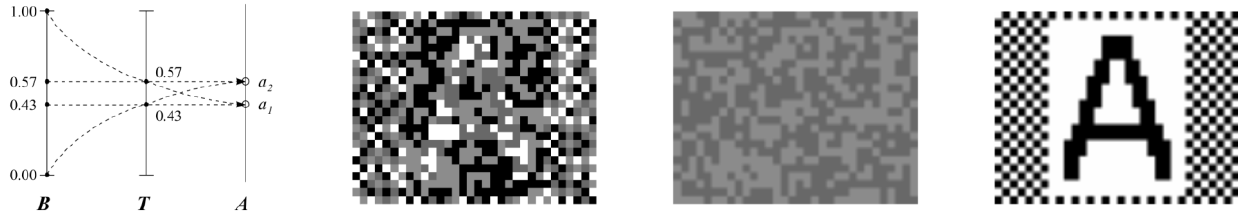
Figure 9. Bias-scrambling, trigger-ambiguous. Left: diagram of rule set f 5 , with arrows linking the intensities that are used. Middle, left: the scrambled bias image from an image sequence generated by rule set f 5 . Middle, right: the random trigger image. Right: the target afterimage pattern, with a 1 , a 2 shown as before. Please note that the actually experienced afterimage may be quite different: see the text.